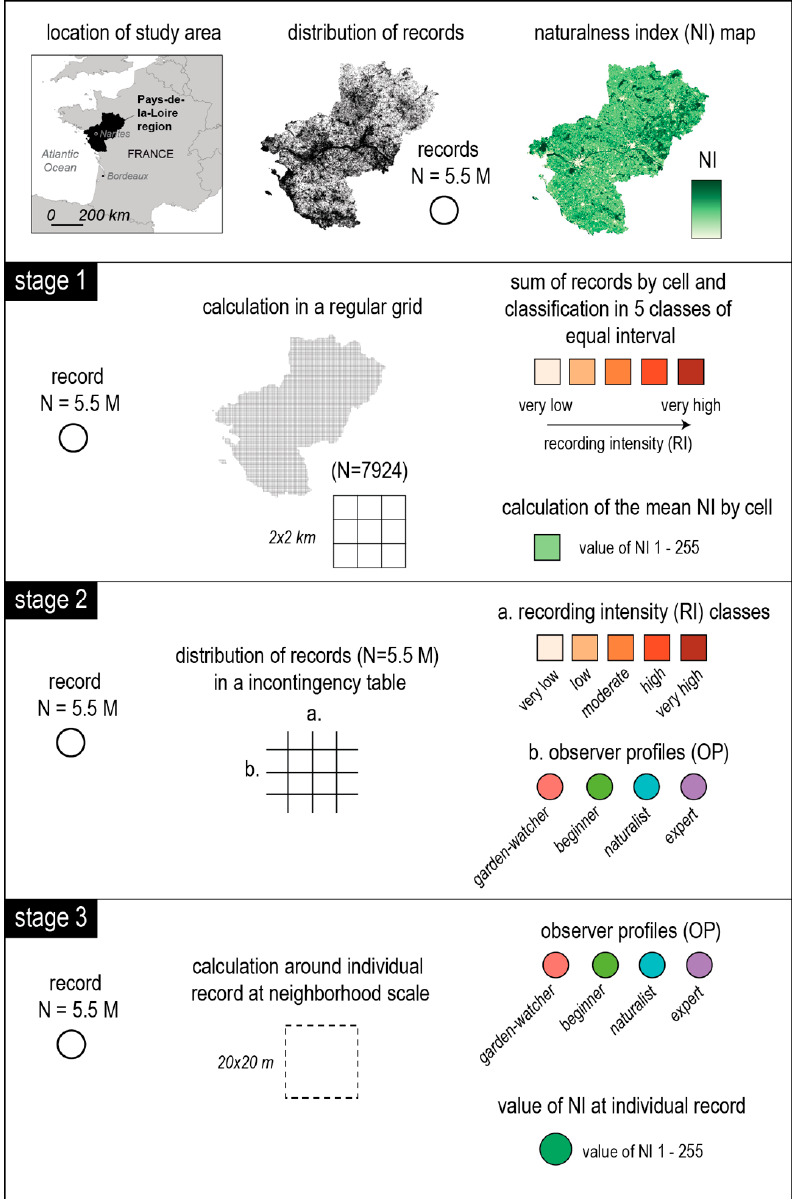
Figure 1. Sequence of data processing and analysis in three key stages (stage 1: effects of the mean NI on the spatial distribution of recording effort (RE), at regional scale; stage 2: distribution of the records according to observer profiles (OP) and the RE classes; stage 3: effect of the mean NI on the RE of OP). N.B. OP = observer profile, NI = naturalness index, RE = recording effort, RI = recording